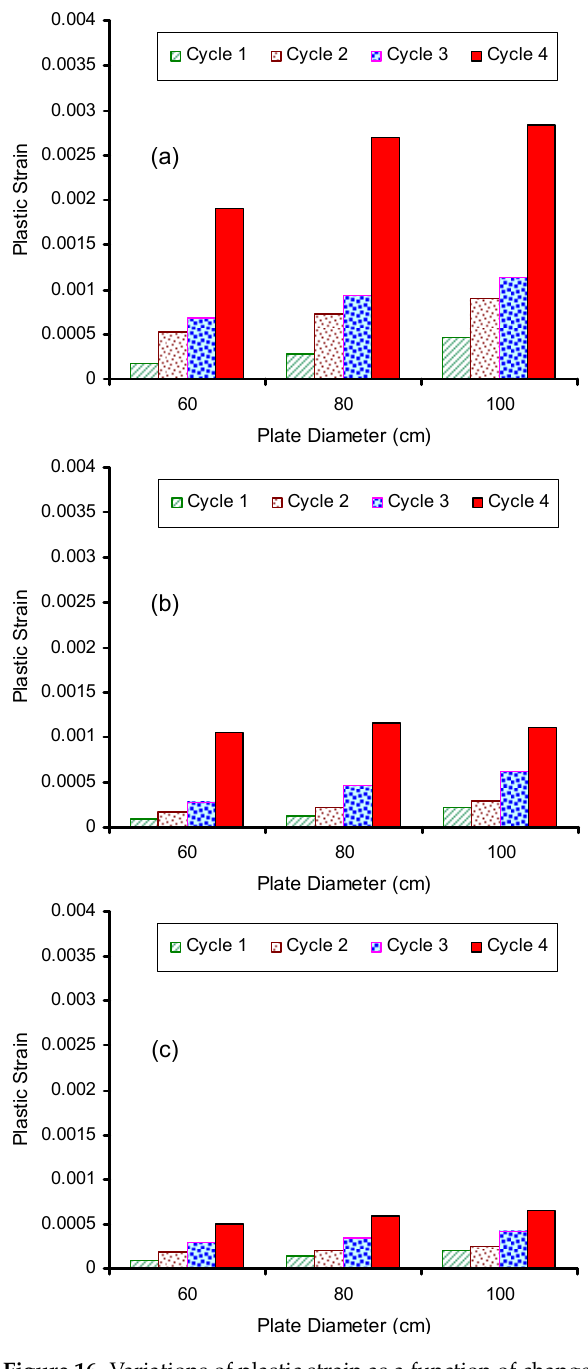
Figure 16. Variations of plastic strain as a function of change in loading plate diameter measured at a depth of; ( a ) 20 cm beneath the plate, ( b ) 40 cm beneath the plate, and ( c ) 60 cm beneath the plate.